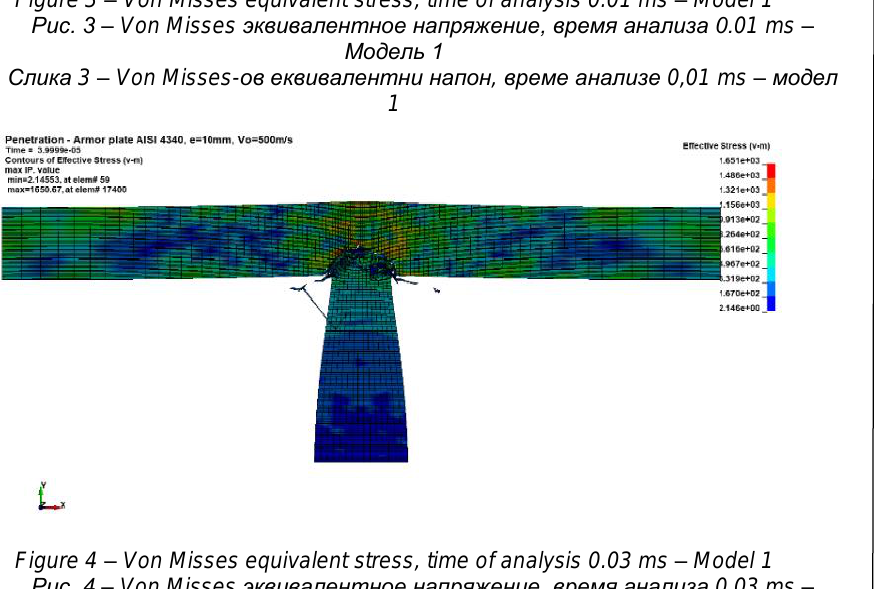
Figure 4 – Von Misses equivalent stress, time of analysis 0.03 ms – Model 1 Рис. 4 – Von Misses эквивалентное напряжение, время анализа 0.03 ms – Модель 1 Слика 4 –Von Misses-ов еквивалентни напон, време анализе 0,03 ms – модел